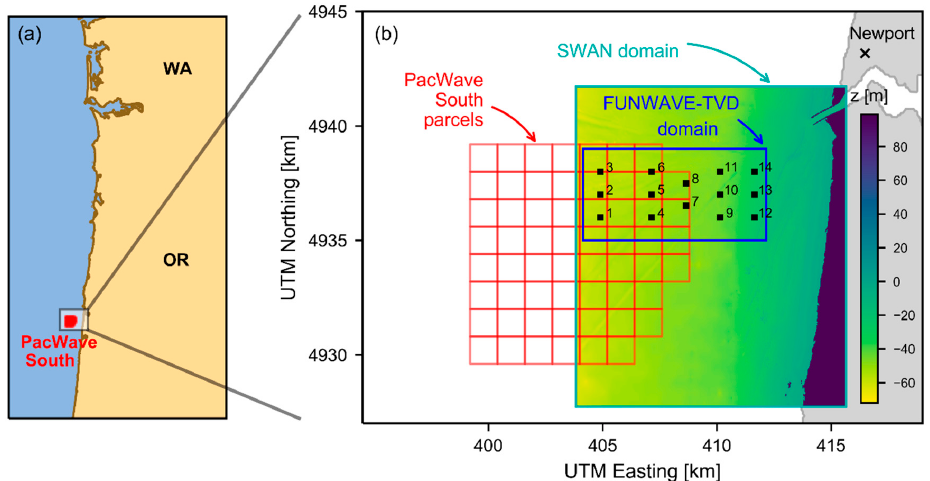
Figure 1. ( a ) Location map and ( b ) detailed view of the study site. PacWave South parcels are shown in red in the inset. SWAN and FUNWAVE model domain extents are shown in cyan and blue, respectively, with a colormap of bathymetry distribution. The layout of the virtual WEC array is represented by the black squares.